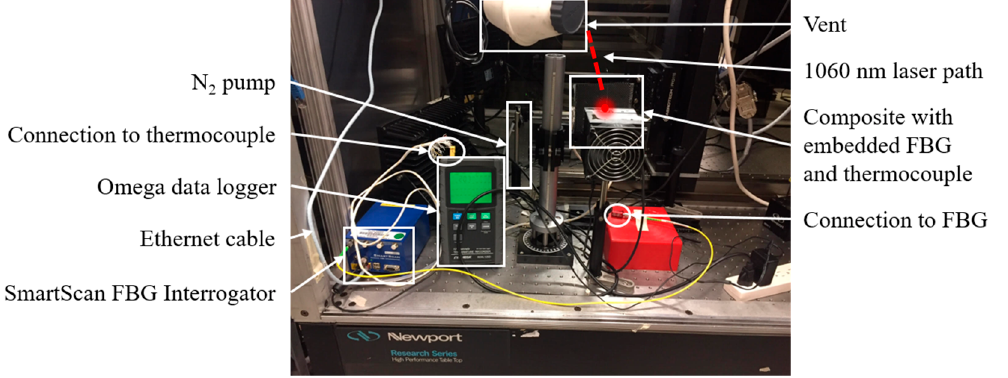
Figure 3. Experimental setup.